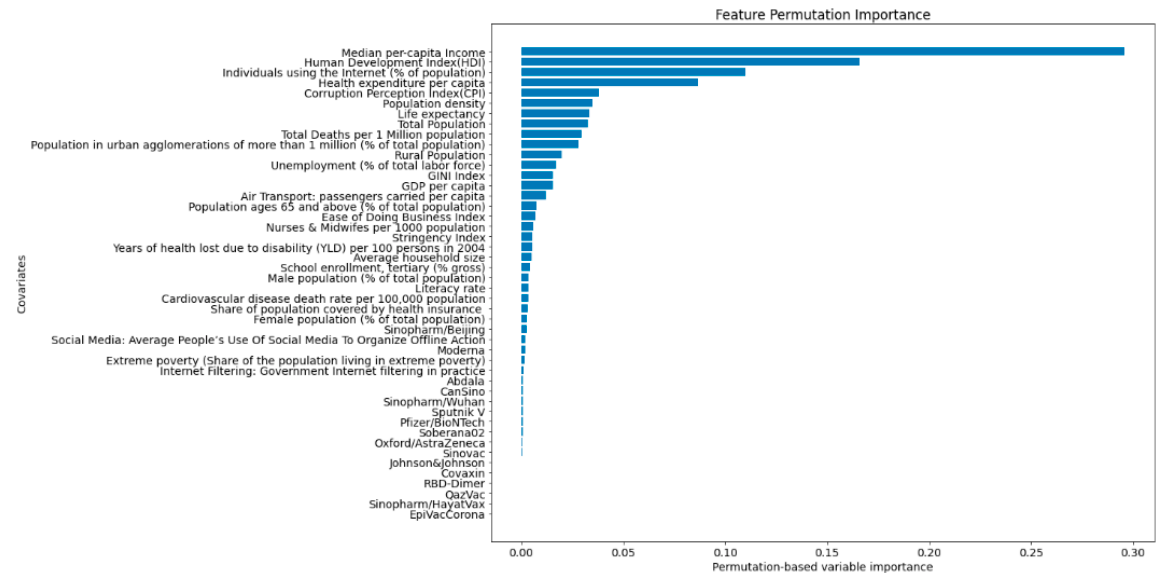
Figure 4. Covariates listed according to their Permutation Feature Importance. Four top features are: (i) median per capita income; (ii) human development index; (iii) the percentage of individuals